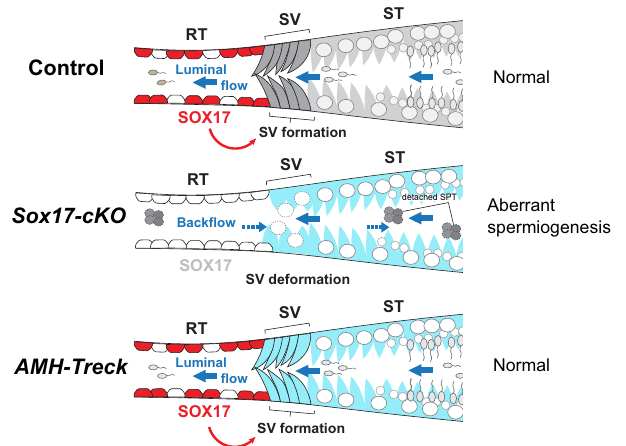
Fig. 8 | SOX17actsasa positiveregulatorofthe formationoftheSV. Schematic diagram summarizing the fi ndings of this study. Sox17 expression in the RT mod- ulates the formation of the SV, which regulates the unidirectional out fl ow of the luminal fl uid from the ST into the RT. Ablation of Sox17 in the RT results in defor- mation of the SV and back fl ow of the luminal fl uid from the RT to the ST. This causes aberrant spermiogenesisin the STs.Relocation of Sertolicellsof Sox17- cKO mice into Sertoli cell-ablated AMH-Treck mouse testis results in the reconstitution of the SV, while restoring spermatogenesis in the ST. Red arrows indicate putative paracrine factors downstream of Sox17 action that promote SV formation. RT rete testis, ST convoluted seminiferous tubule, SV Sertoli